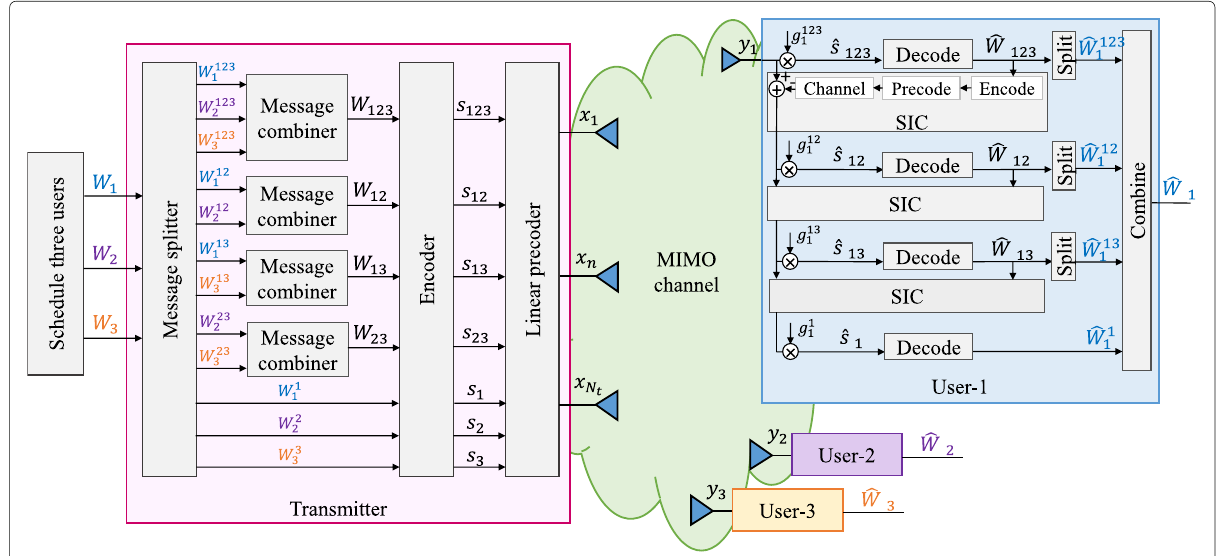
Fig. 2 Three-user transmission model using